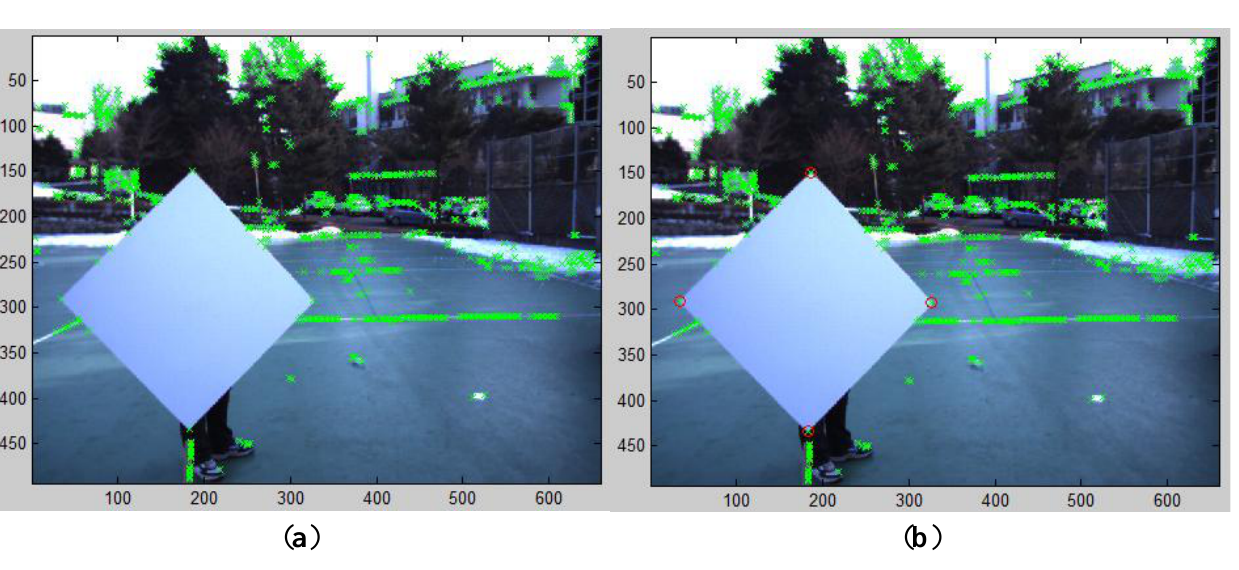
Figure 13. Selection of four corners on the diamond board in 2D image: ( a ) Detected corners in the image with FAST method (green cross markers); ( b ) Selected 4 corners on the diamond board (red circle markers).